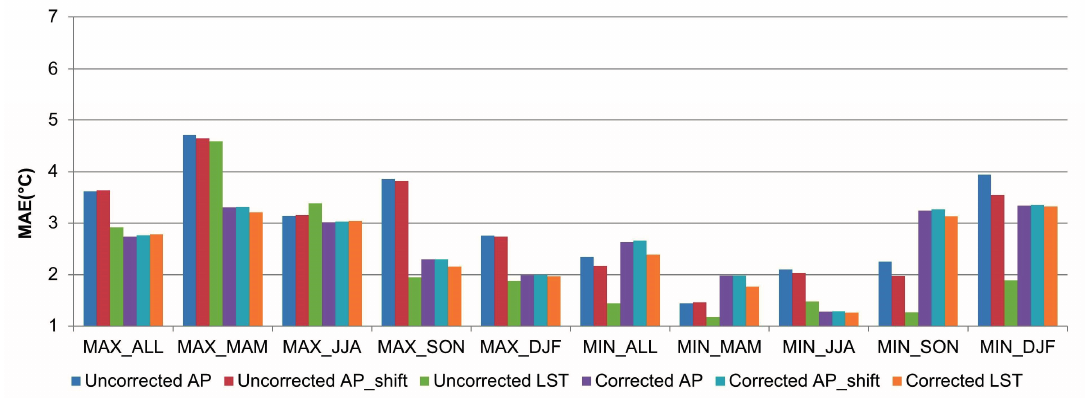
Figure 7. MAE values averaged for 60 ASOS weather stations’ locations for estimating monthly air temperature with or without the correction using the NCEP/NCAR reanalysis data (unit: